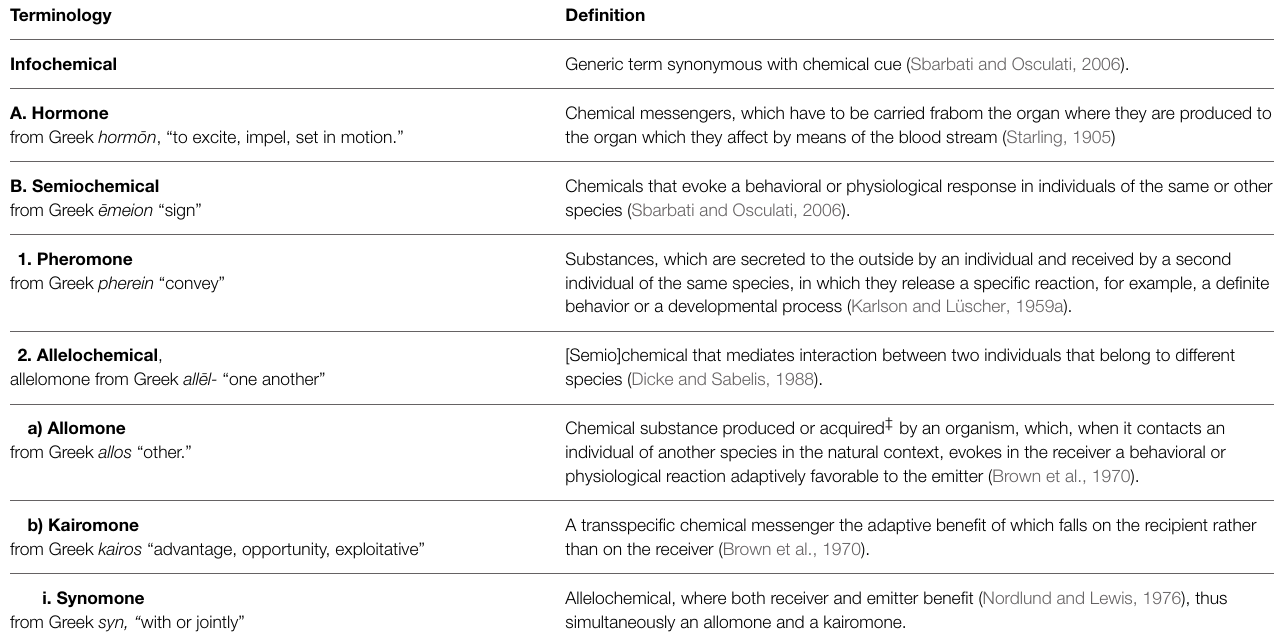
TABLE 1 | Hierarchical overview of terminology commonly used to classify chemical effects within and between organisms. Terminology Definition Infochemical Generic term synonymous with chemical cue (Sbarbati and Osculati,